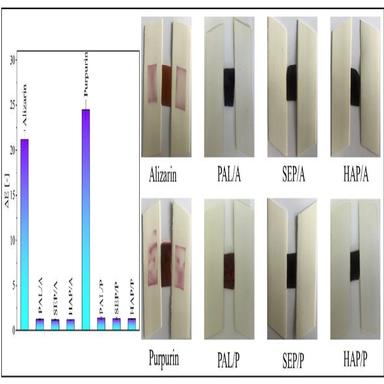
Total color changes and digital photographs of the pigmented EN compositions subjected to bleeding tests at 100 C.